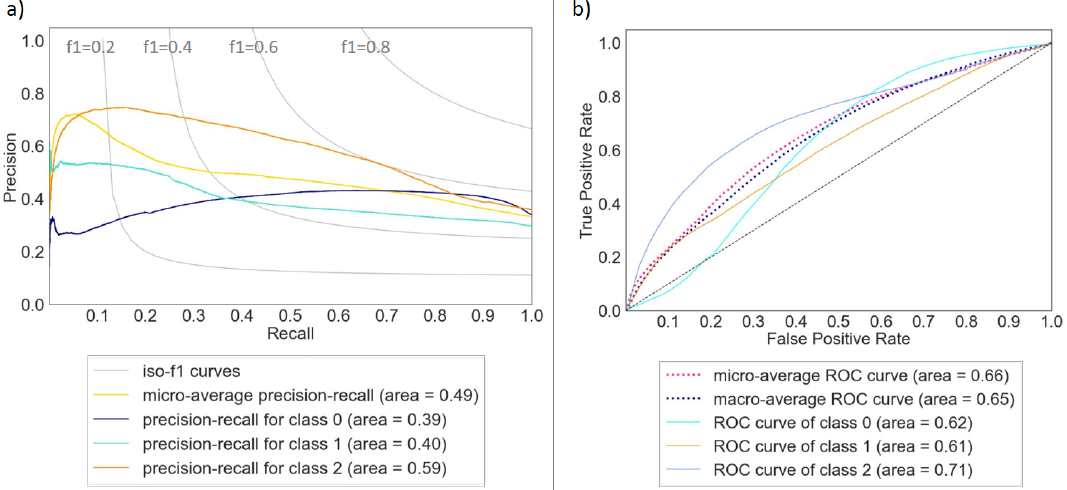
Figure 3. Logistic regression simulation results: ( a ) precision–recall curve; ( b ) ROC